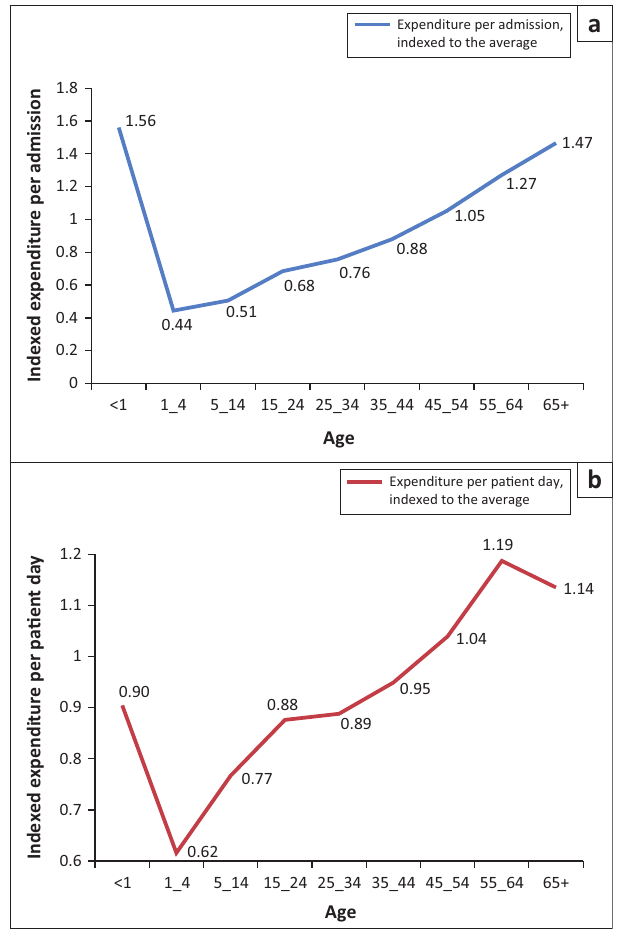
FIGURE 7: Indexed (a) average expenditure of admissions and (b) patient days,